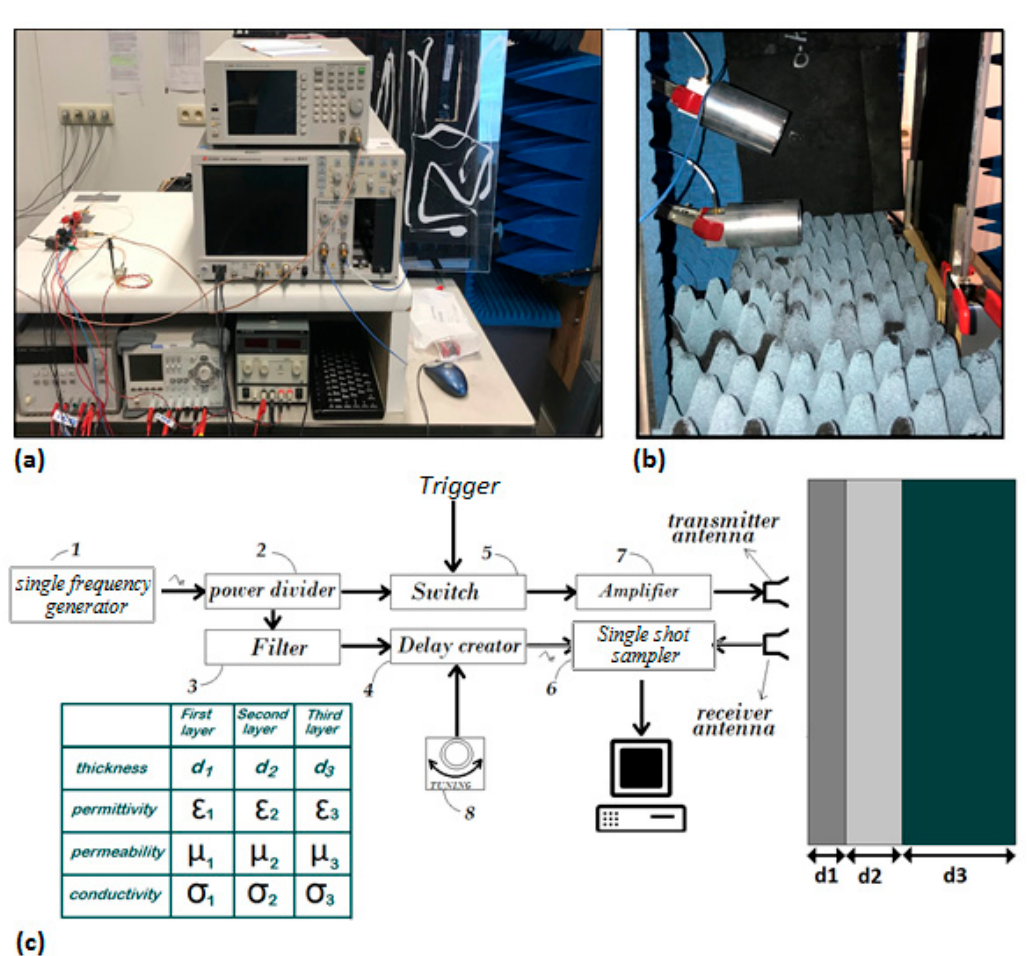
Figure 1. ( a ) The general set-up of TRM. ( b ) The transmitter and receiver antennas in the measurement set-up. ( c ) A block diagram explaining the set-up. Thickness, permittivity, permeability and conductivity of each layer can be measured by means of TRM.